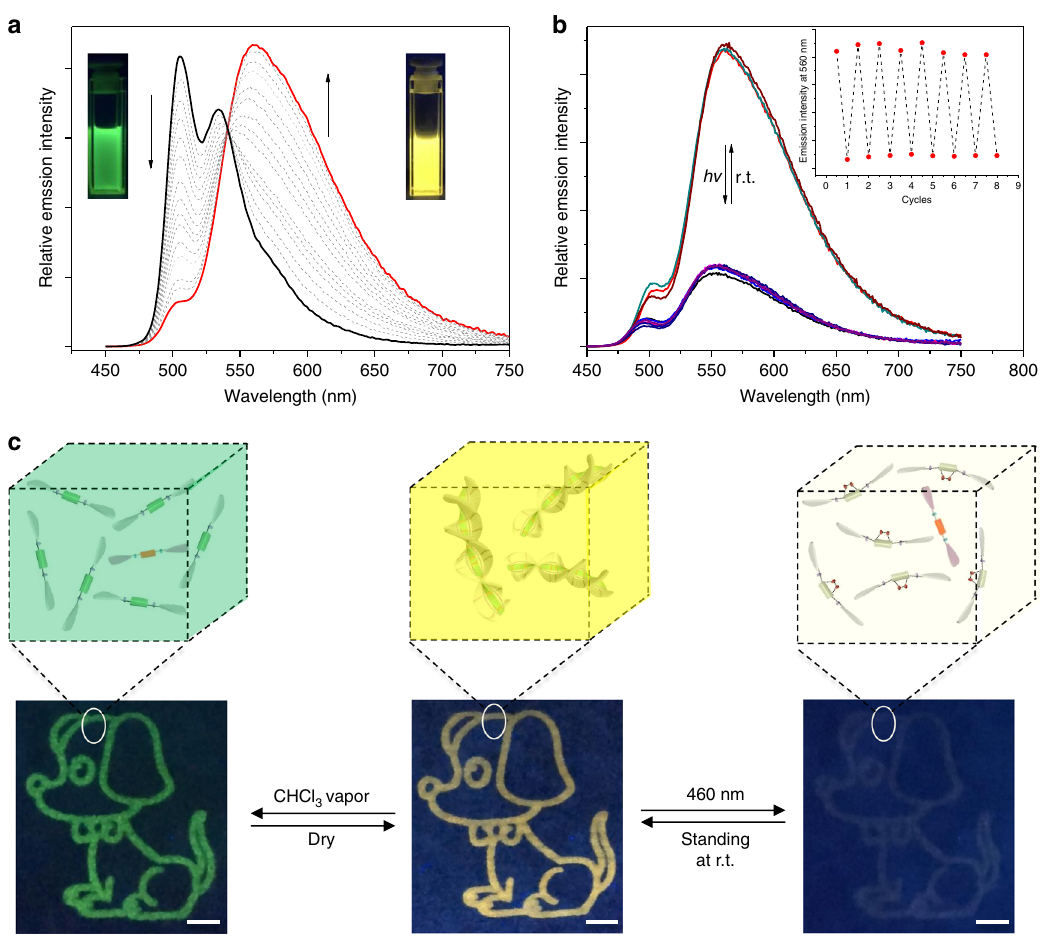
Fig. 9 Dual-mode anti-counterfeiting inks from 1 / 2 . a Fluorescent spectra of 1 (4.00 × 10 − 5 M in MCH) via the gradual addition of 2 (0 – 10 mol%). b Fluorescent spectra of 1 / 2 (10 mol% of 2 , 4.00 × 10 − 5 M for 1 , λ ex = 425 nm) upon successive 460 nm light irradiation and room-temperature standing. Inset: intensity changes at 560 nm. c Dual-stimuli responsive dog pattern by inkjet printing 1/2 (4.00 × 10 − 5 M of 1 in MCH, 2.5 mol% of 2 ) on the weighting paper, together with the cartoon representation for the corresponding structures. The images are taken under 365 nm UV handhold lamp. Scale bars: 5 mm